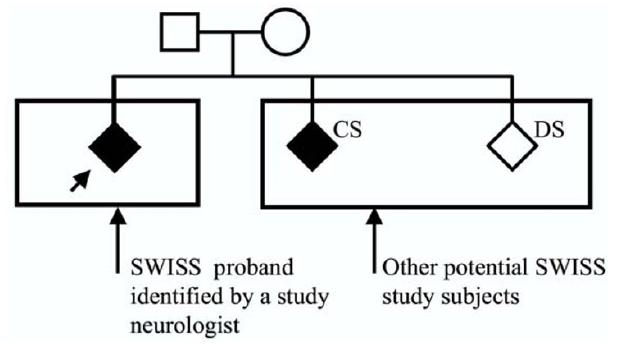
Figure 1 Sample study pedigree for the Siblings With Ischemic Stroke Study (SWISS). Solid symbols indicate ischemic stroke; CS, concordant sibling; and DS, discordant